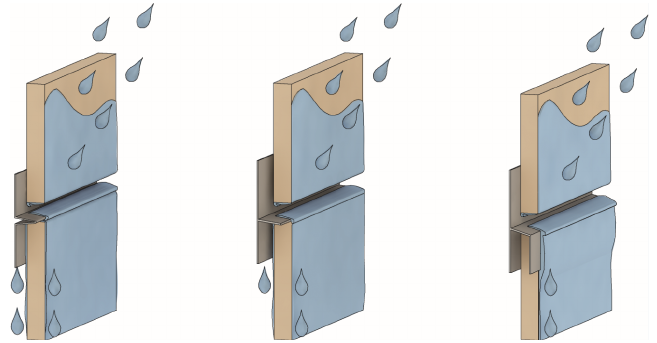
Figure 15. Water intrusion when the profiles are pressed downward in the